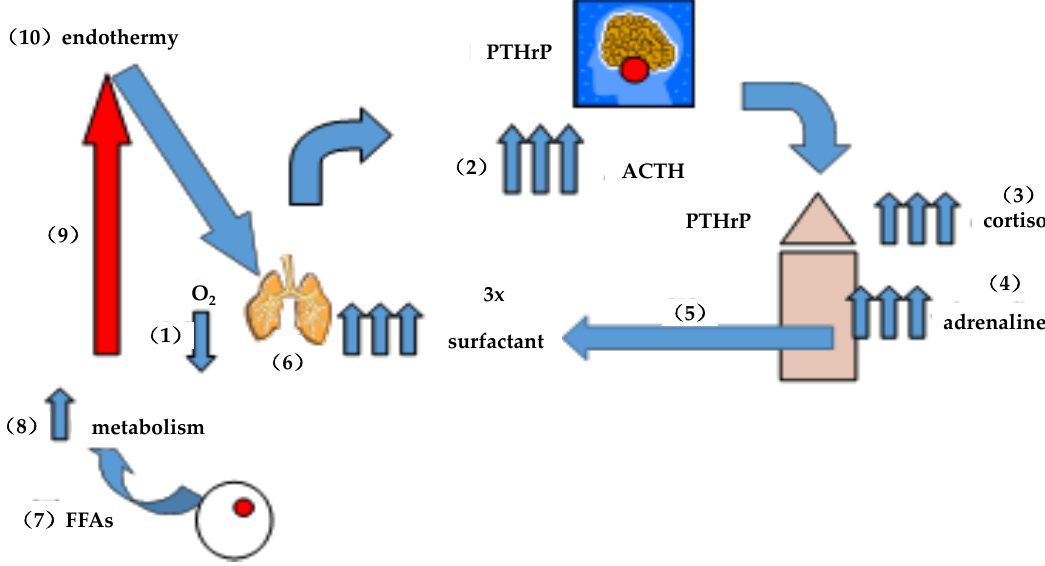
Figure 2. On the evolution of endothermy: ( 1 ) intermittent hypoxia caused physiologic stress; ( 2 ) stimulating pituitary ACTH; ( 3 ) ACTH stimulated corticoid production; ( 4 ) stimulating adrenaline production; ( 5 ) adrenaline stimulated surfactant secretion by the alveoli; ( 6 ) increasing alveolar distension/surface, area for gas exchange alleviating the hypoxic stress acutely; ( 7 ) adrenaline also stimulates fatty acid (FFA) secretion by adipocytes; ( 8 ) increasing metabolism; ( 9 ) and therefore body temperature; and ( 10 ) ultimately giving rise to endothermy. Surfactant phospholipid is three times more surface active at 37 °C than it is at 25 °C, accommodating lung evolution.